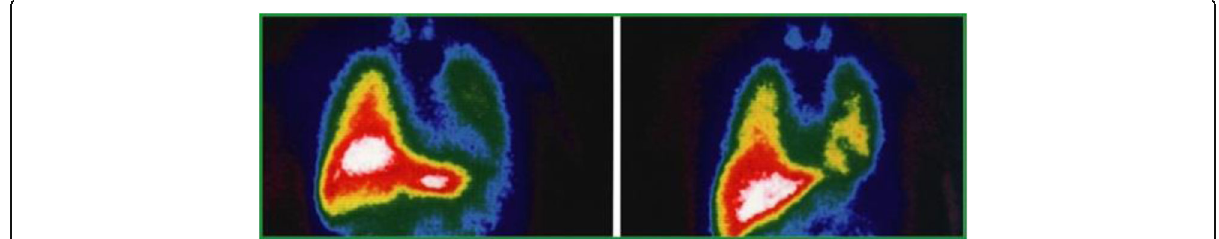
Fig. 5 The administration of iodine-123 metaiodobenzylguanidine ( 123 I-MIBG) and its uptake in Parkinson ’ s disease (PD) (left) and multiple system atrophy (MSA) (right). Normal heart uptake in the MSA patient is seen. The image shows extensive liver uptake in both patients [104]